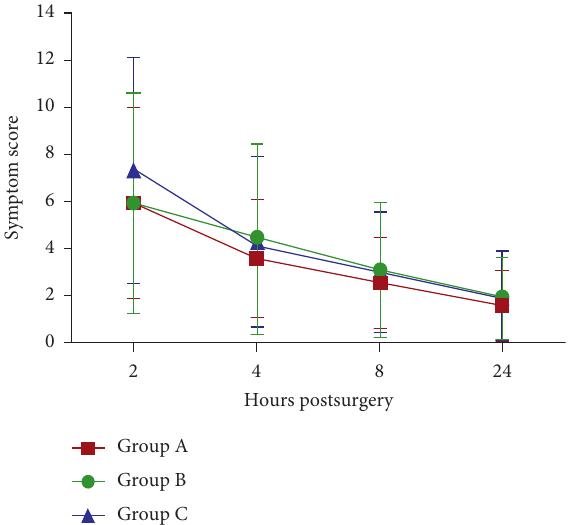
Figure 1: The total symptom scores after SMILE among the 3 groups at different postsurgery time points.